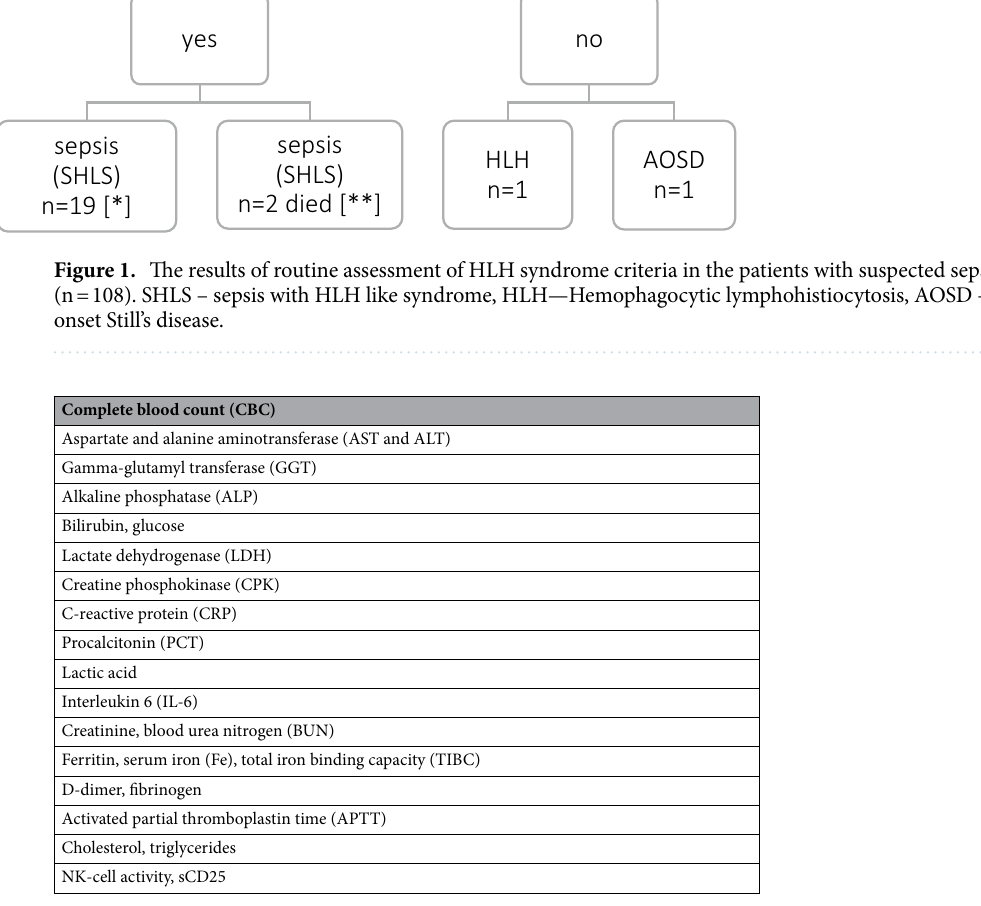
Table 2. The set of routine blood tests on admission in patients with suspected